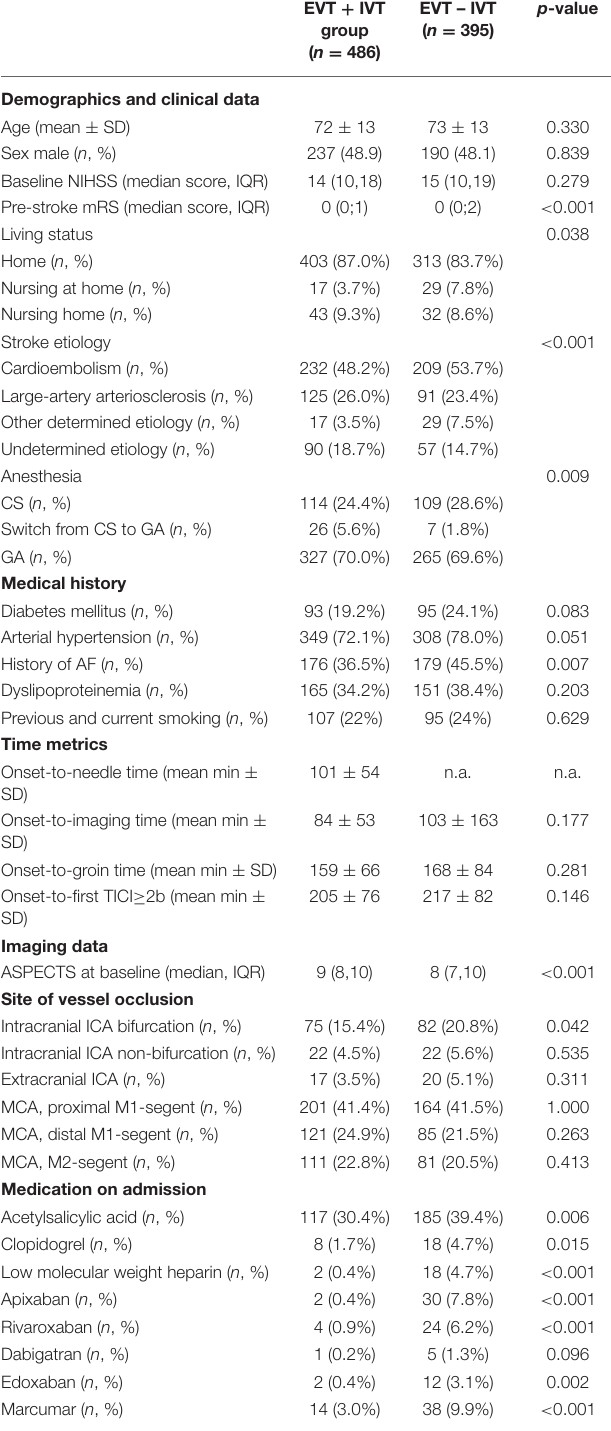
TABLE 1 | Baseline characteristics of with (EVT + IVT) and without (EVT – IVT) bridging thrombolysis.